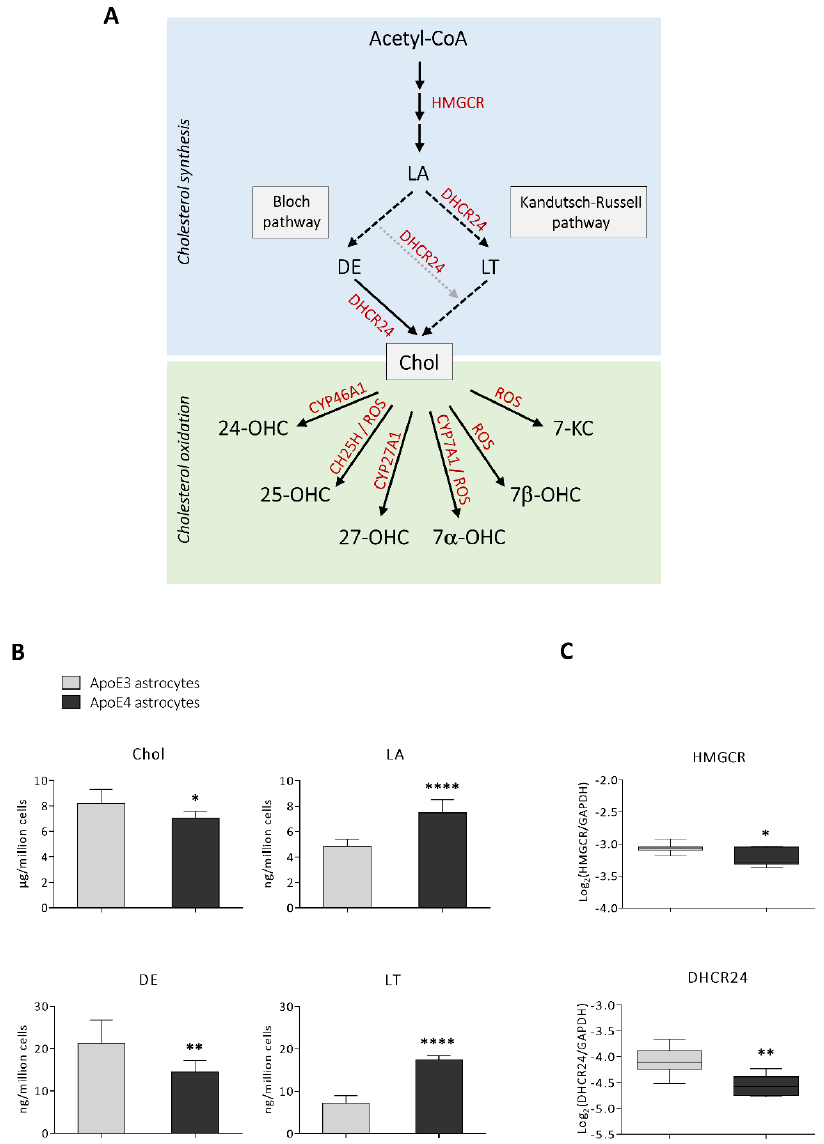
Figure 3. Quantification of cholesterol and its precursors, and analysis of key enzymes expression. ( A ) Schematic representation of cholesterol synthesis and oxidation. Acetyl-CoA: Acetyl coenzyme A; Chol: cholesterol; CH25H: cholesterol 25-hydroxylase; CYP46A1: cholesterol 24-hydroxylase; CYP27A1: cholesterol 27-hydroxylase; CYP7A1: cholesterol 7 -hydroxylase; DE: desmosterol; DHCR24: 24-dehydrocholesterol reductase; HMGCR: 3-hydroxy-3-methylglutaryl-CoA reductase; LA: lanosterol; LT: lathosterol; ROS: reactive oxygen species; 7-KC: 7-ketocholesterol; 7 -OHC: 7 - hydroxycholesterol; 7 -OHC; 7 -hydroxycholesterol; 24-OHC: 24-hydroxycholesterol; 25-OHC: 25- hydroxycholesterol; 27-OHC: 27-hydroxycholesterol. ( B ) Total cholesterol and cholesterol precur- sors (LA, LT, and DE) were quantified by gas chromatography-mass spectrometry (GC-MS) in ApoE3 and ApoE4 immortalized mouse astrocytes. Data are expressed as mean values ± SD of three different experiments ( n = 9 , Student’s t -test). **** p < 0.0001, ** p < 0.01, and * p < 0.05 vs. ApoE3 astrocytes. ( C ) Gene expression levels of the enzymes HMGCR and DHCR24 were analysed in